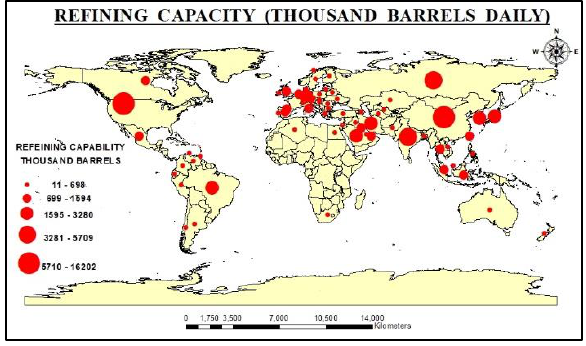
Figure 7. Refinery throughput (Thousand barrels per day) The producers of crude oil, export it to the refining nations. The flow of crude oil from major producers is depicted in a Sankey diagram in Figure 8. On the left are the producers/exporters of crude oil, while on the right are the importers of crude oil. The thickness of the arrows depicts the relative share of the crude oil trade.